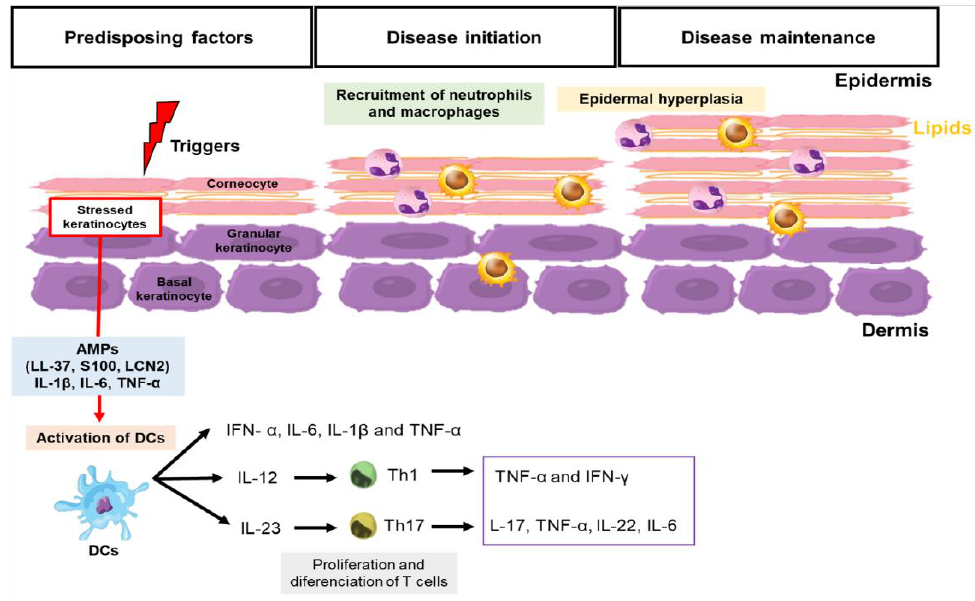
Figure 1. Pathophysiology of psoriasis. The pathophysiology of psoriasis involves excessive activation of the innate and adaptive immune system by extrinsic and intrinsic factors associated with the genetic background (triggers). Dendritic cells (DCs) are activated and secrete IFN- α, IL -6, IL- 1β , and TNF- α. Then, dendritic cells induce the proliferation and differentiation of naive T cells. The activation of interleukin (IL)-12/Th1/interferon(IFN)- γ , and IL-23/Th17/IL-17 pathways lead to the induction and maintenance of skin inflammation and to an increase in the number of keratinocytes in the epidermis.